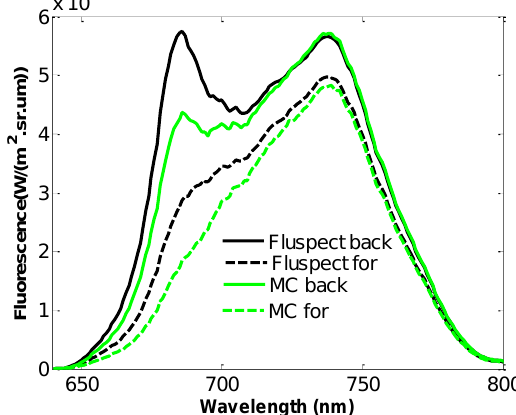
Figure 8. The simulated leaf backward and forward ChlF by the MC model and the Fluspect